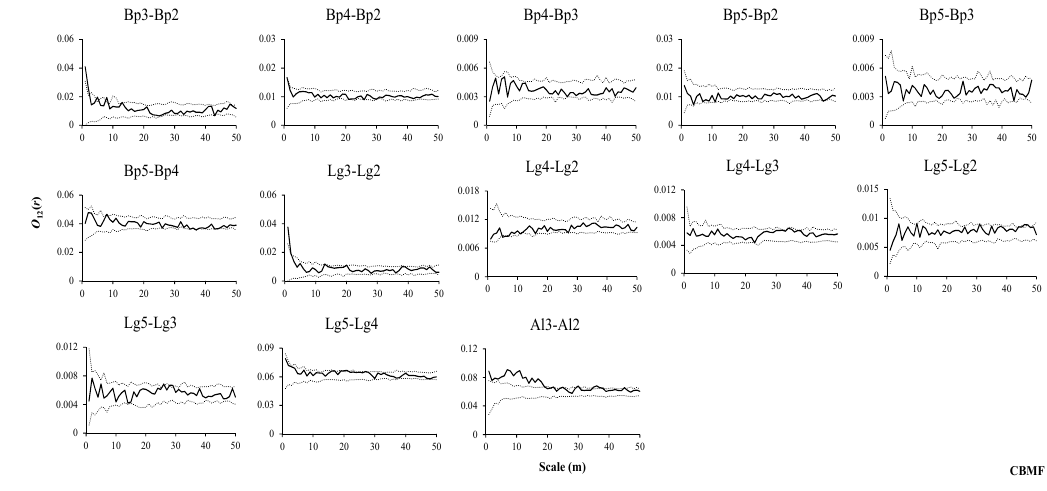
Figure 6. Spatial associations of tree species in CBMF.